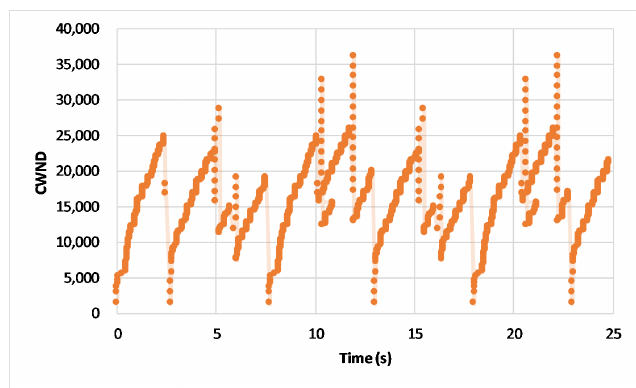
Figure 8. Real-time Congestion WiNDow (CWND) in the conventional